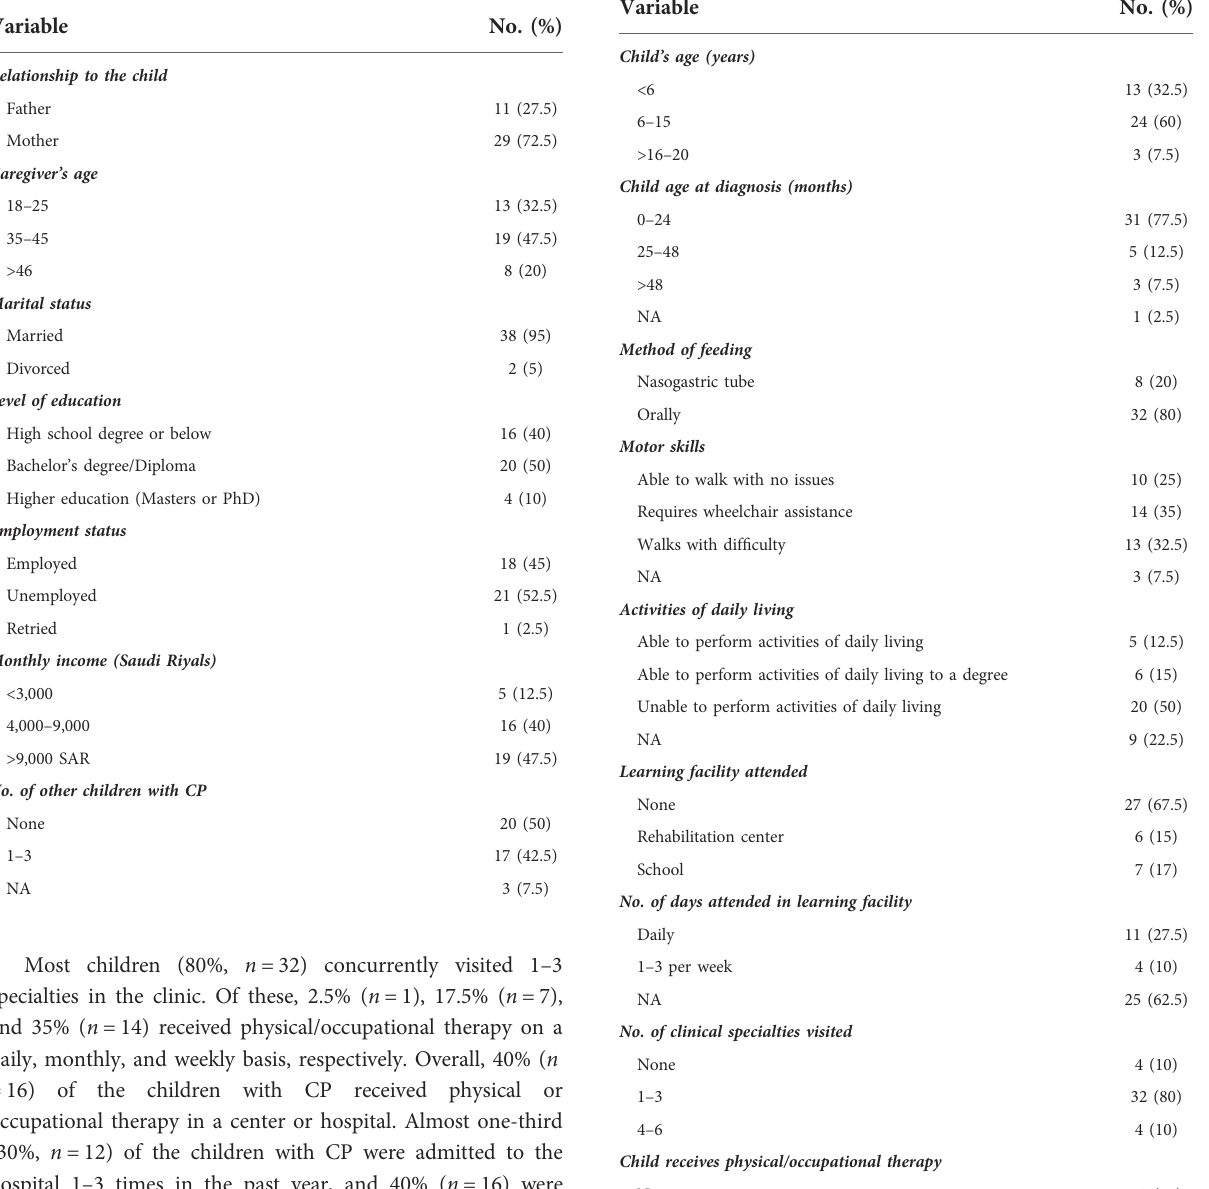
TABLE 2 Health status and characteristics among children with